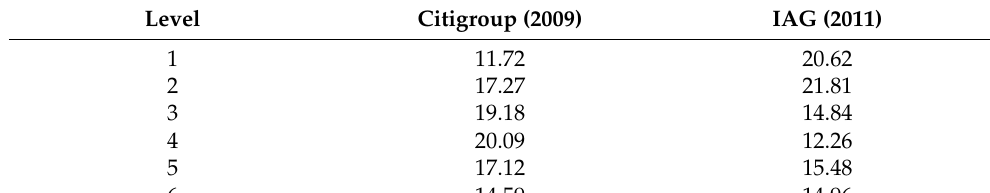
Table 8. Power spectra for Citigroup and IAG stock market data.